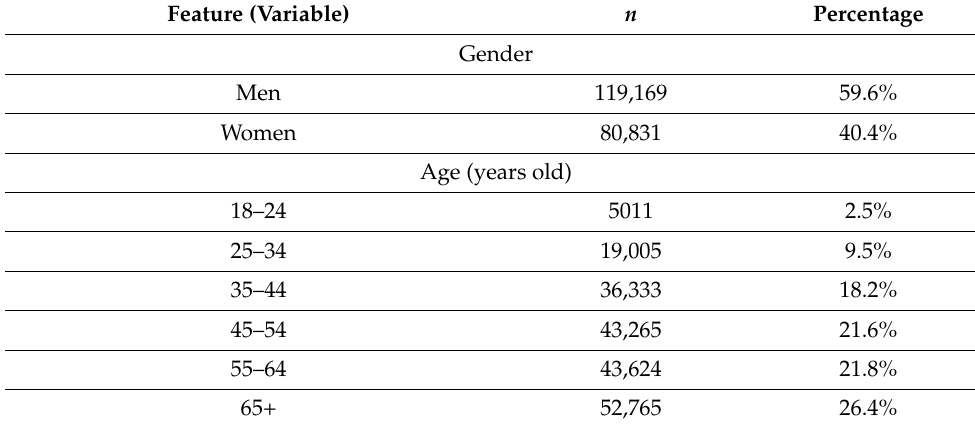
Table 1. General characteristics of the